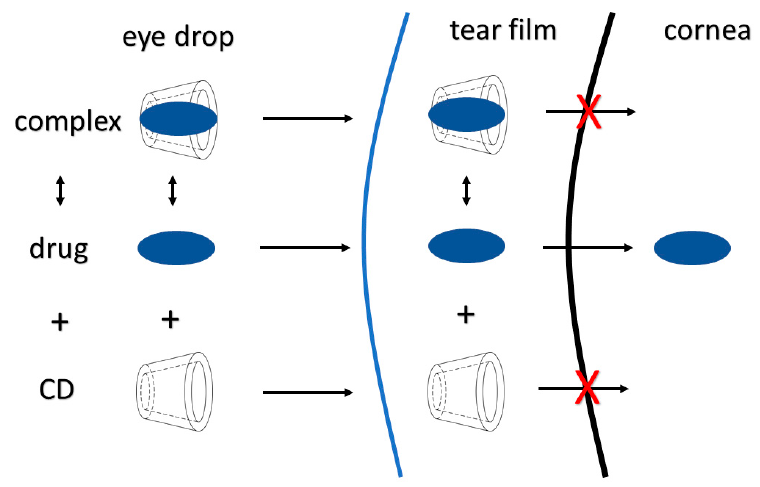
Figure 2. Schematic figure about the cyclodextrin drug permeability enhancer attributes.